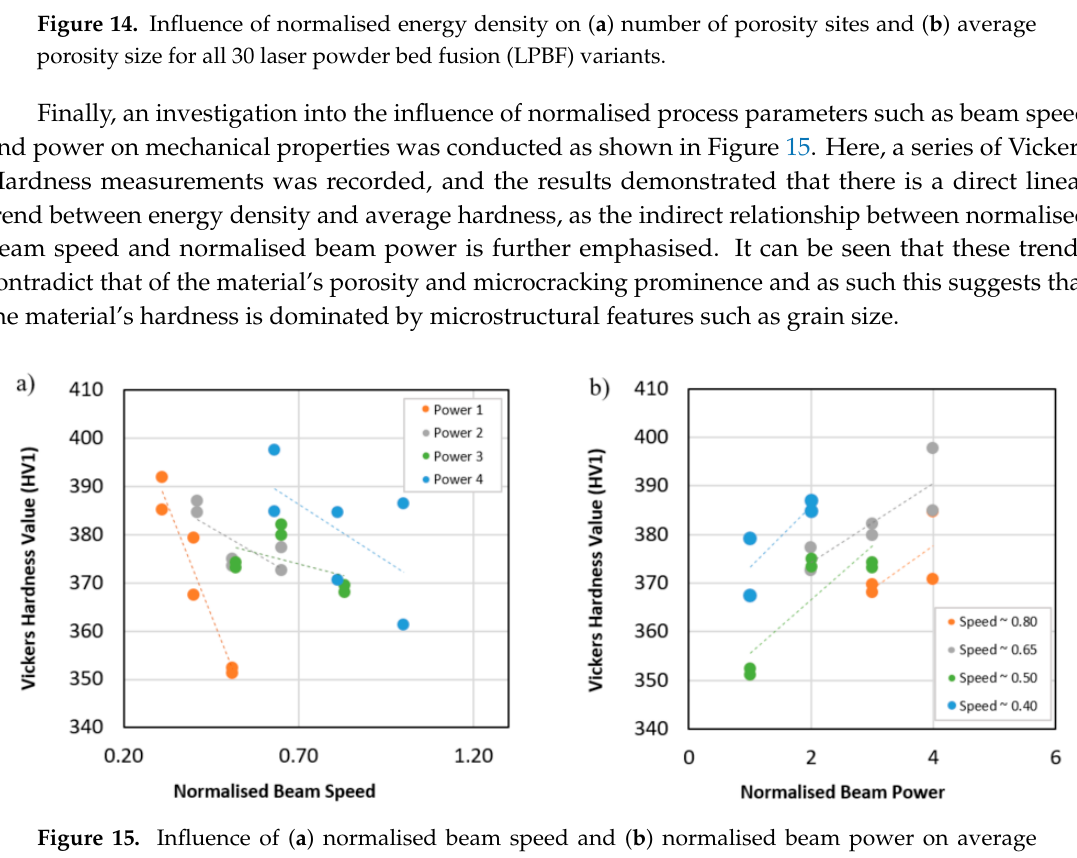
Figure 14. Influence of normalised energy density on ( a ) number of porosity sites and ( b ) average porosity size for all 30 laser powder bed fusion (LPBF) variants.